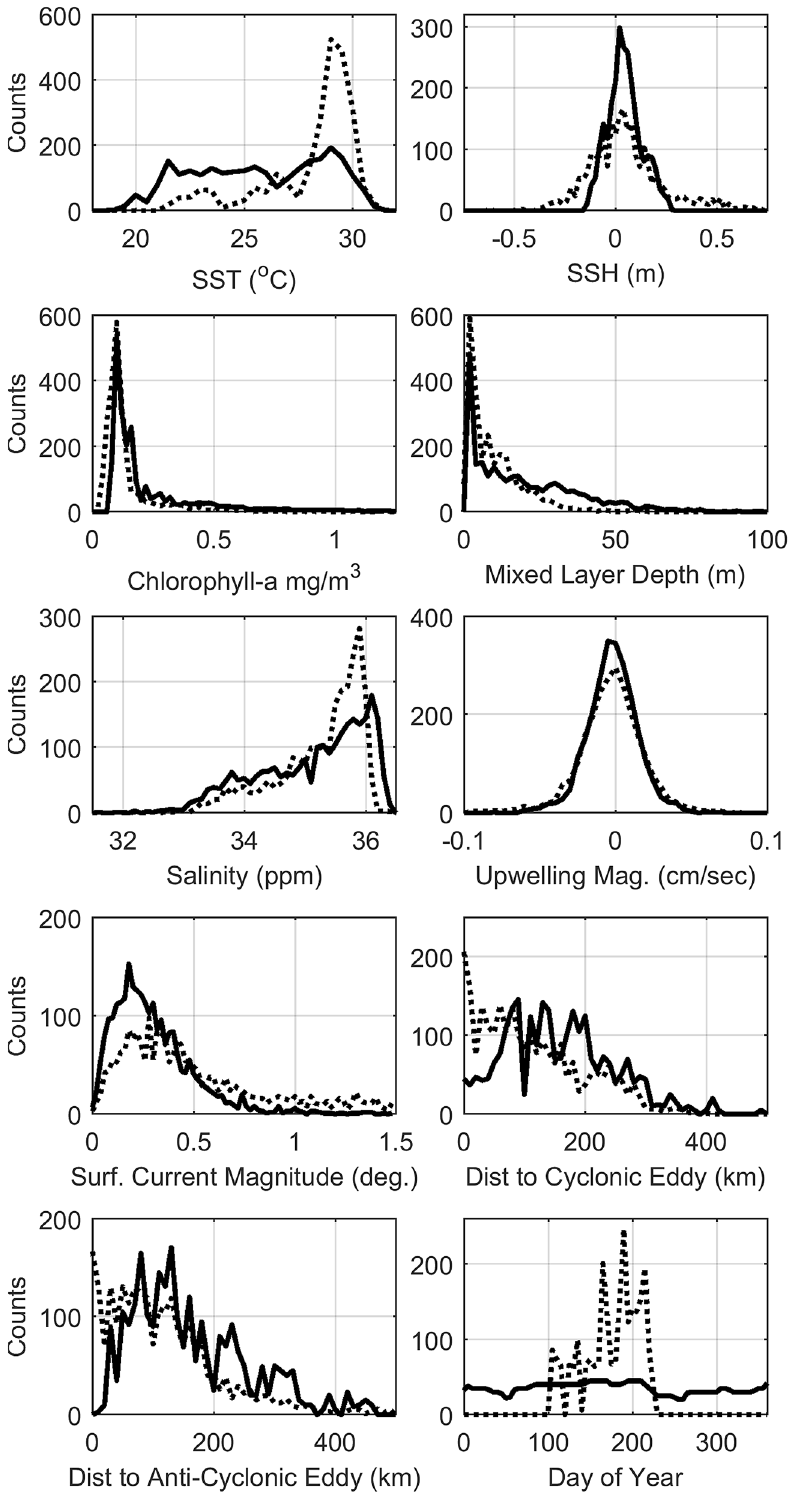
Figure 2. Distributions of predictor variables within the visual (dashed line) and acoustic (solid line) training datasets. Summer visual survey transects covered a wider range of mesoscale oceanographic features including currents and eddies, while year-round recording with PAM sampled a broader range of temperatures, salinities and mixed layer